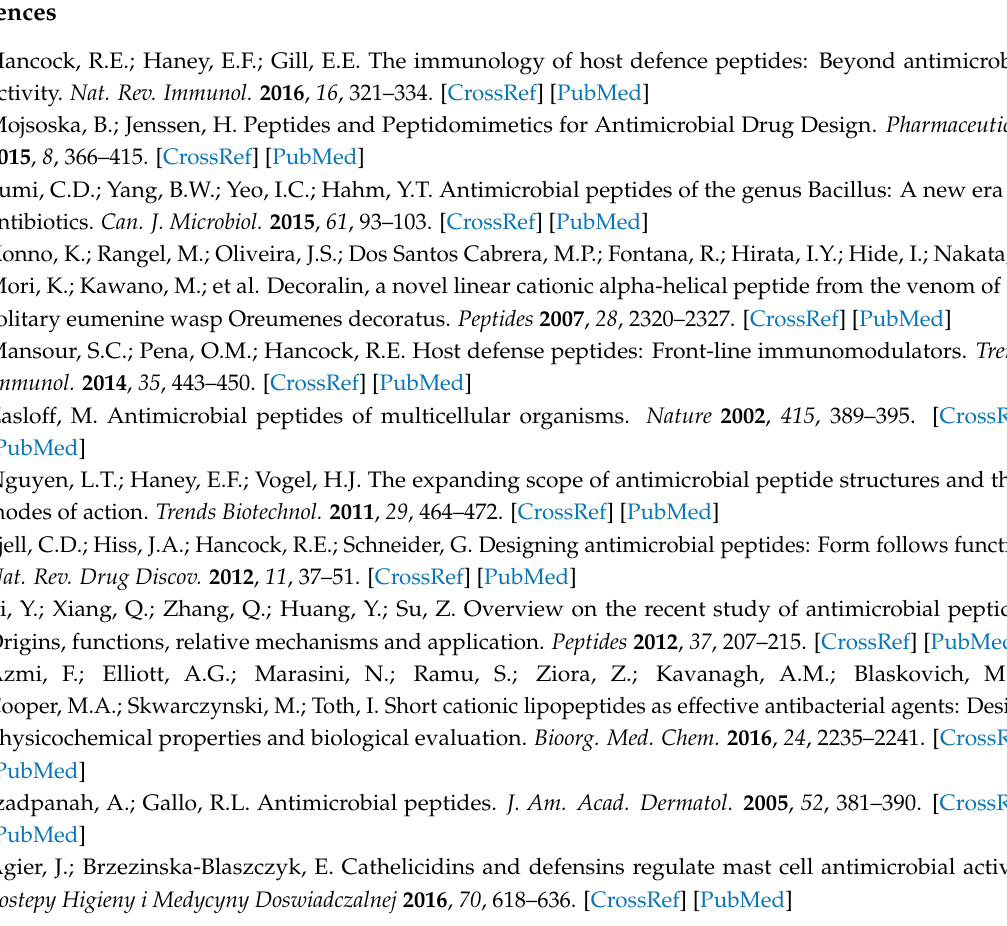
Figure S1: Trp emission spectra of peptides. Figure S2: Peptide binding to Lipid Vesicles by Spectral shifts. Figure S3: Time course of Outer-membrane permeabilization. Figure S4: Time course of Inner-membrane permeabilization. Table S1: Acrylamide